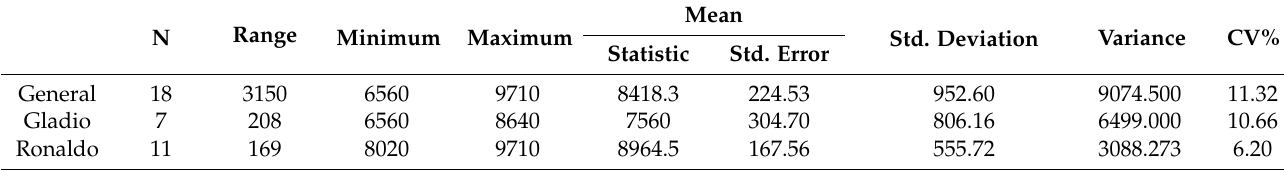
Table 3. Yield descriptive statistics for rice